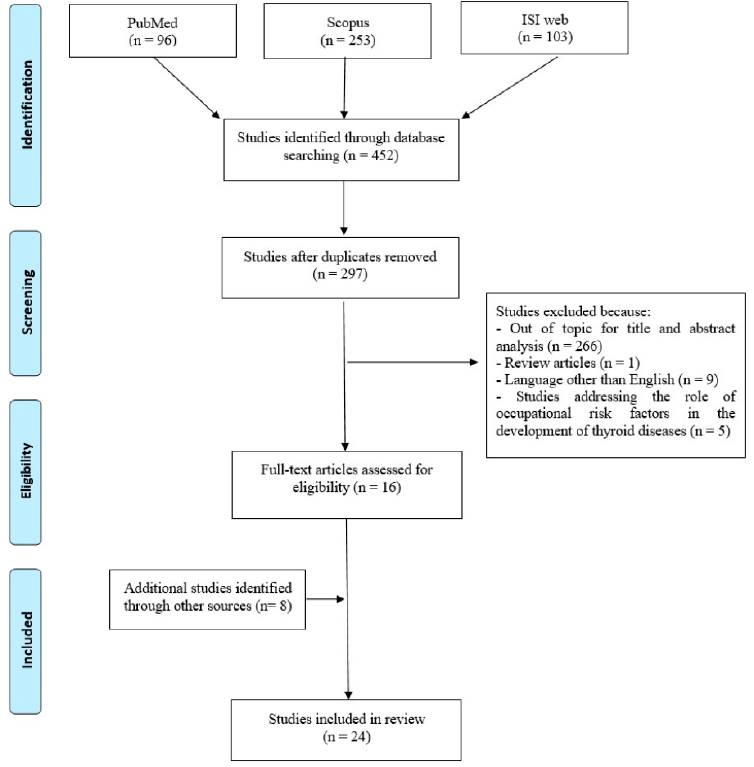
Figure 1. Flow diagram of literature search.